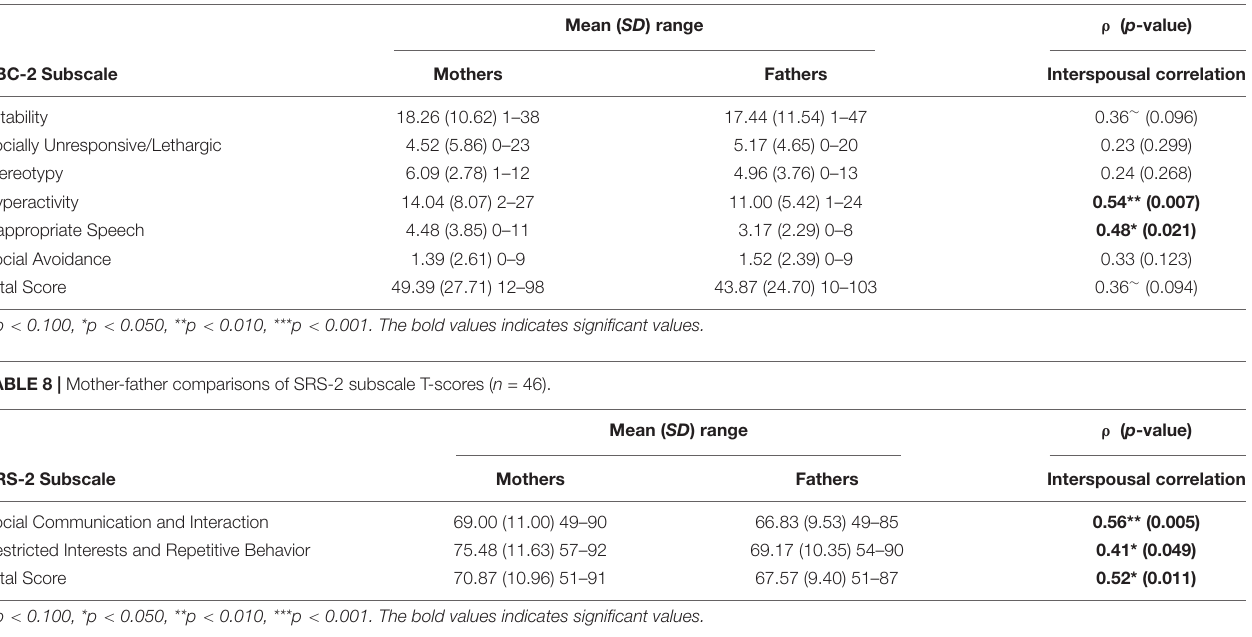
TABLE 7 | Mother-father comparisons of ABC-2 subscale raw scores ( n = 46).